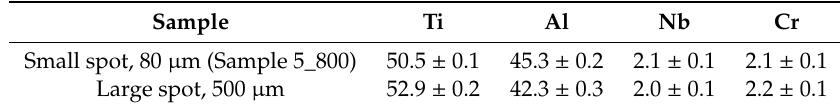
Table 4. The chemical composition (in at. %) of the samples fabricated from GA powder using di ff erent laser spot diameters.